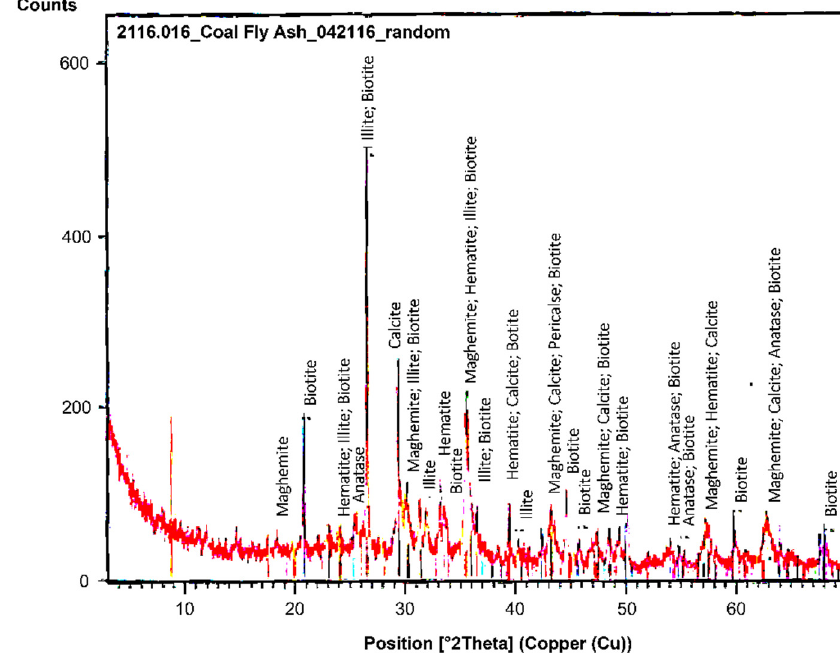
Figure 2. X-ray diffraction pattern of the CFA raw material.